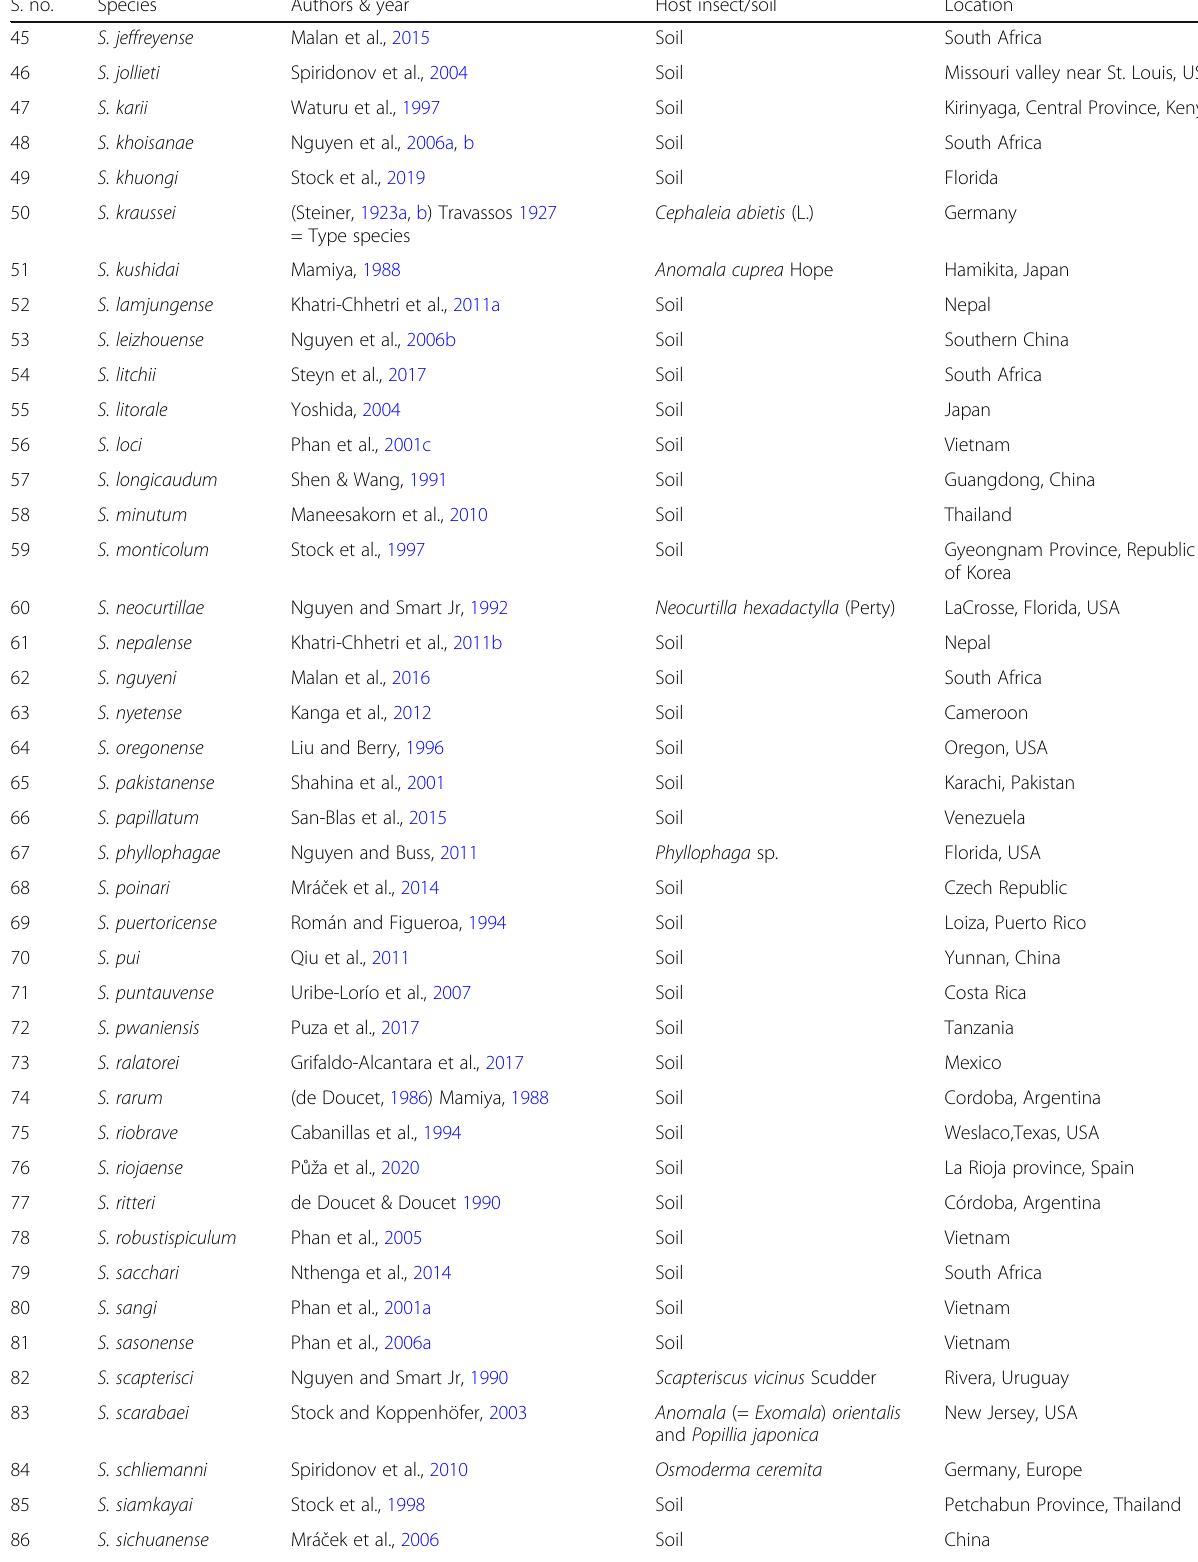
Table 1 List of Steinernema species recorded from different countries of the world (Continued) S.